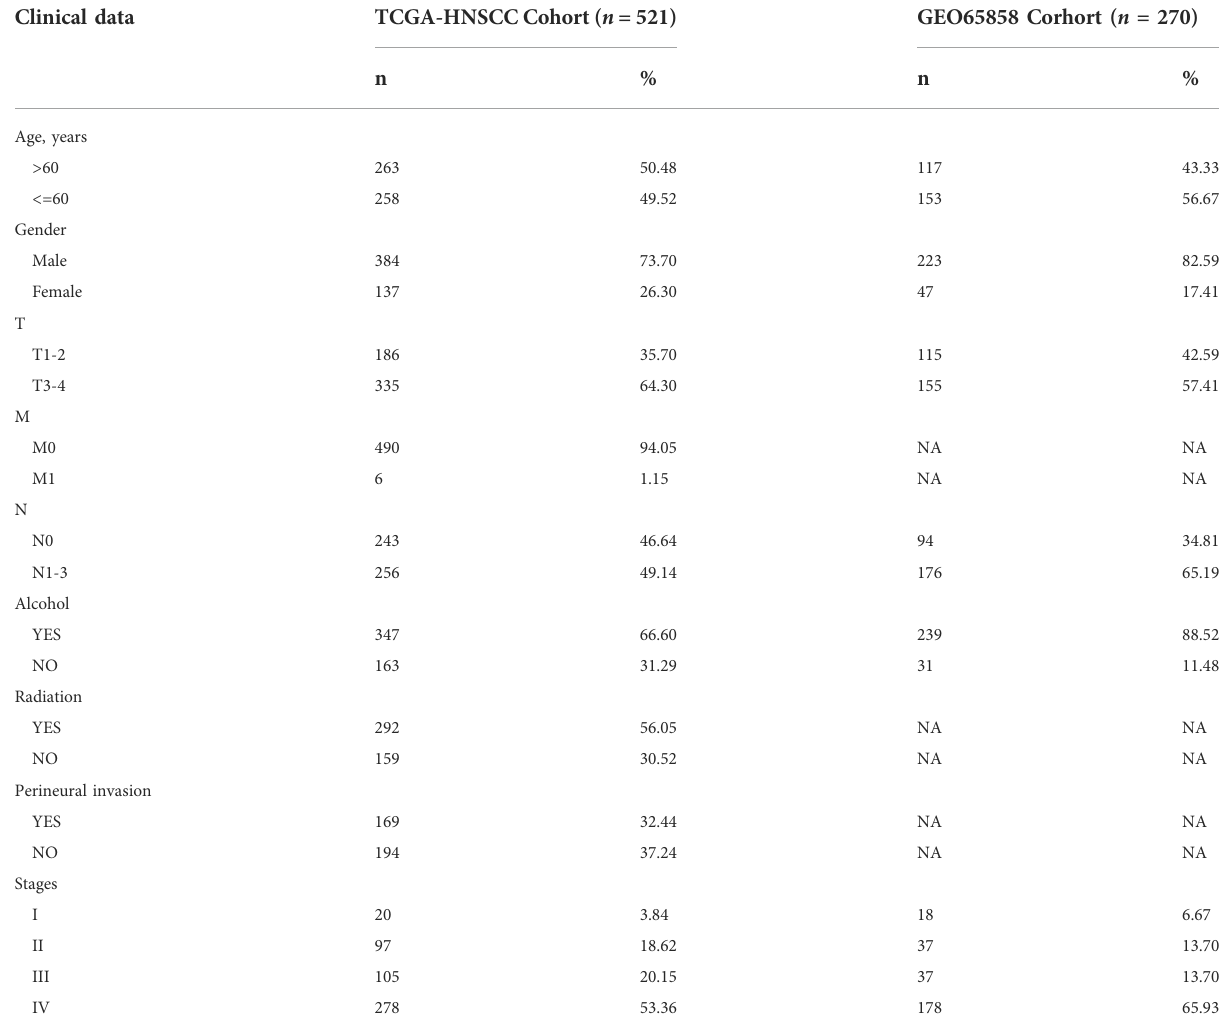
TABLE 1 Transcriptome data set information. Clinical